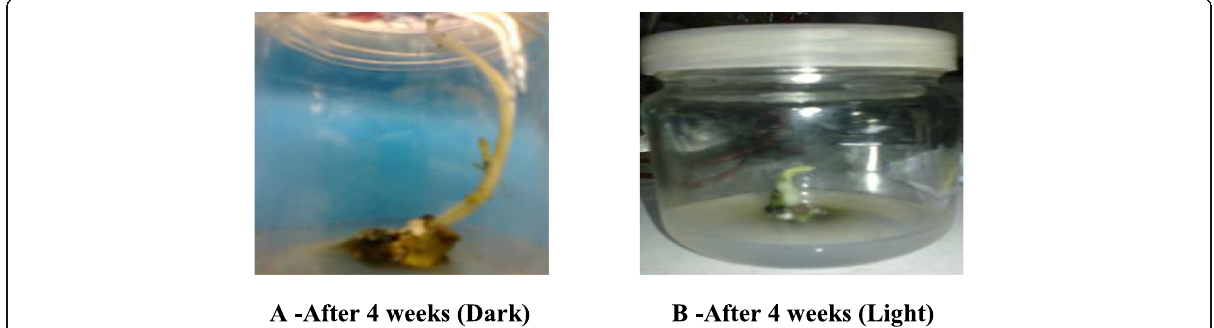
Fig. 1 a , b Effect of supplementation of WPM with 2 mg/l Zt and 5 mg/l 2iP on development stage (calli initiation or shootlet regeneration) from internode explant of Diospyros kaki L. cv.